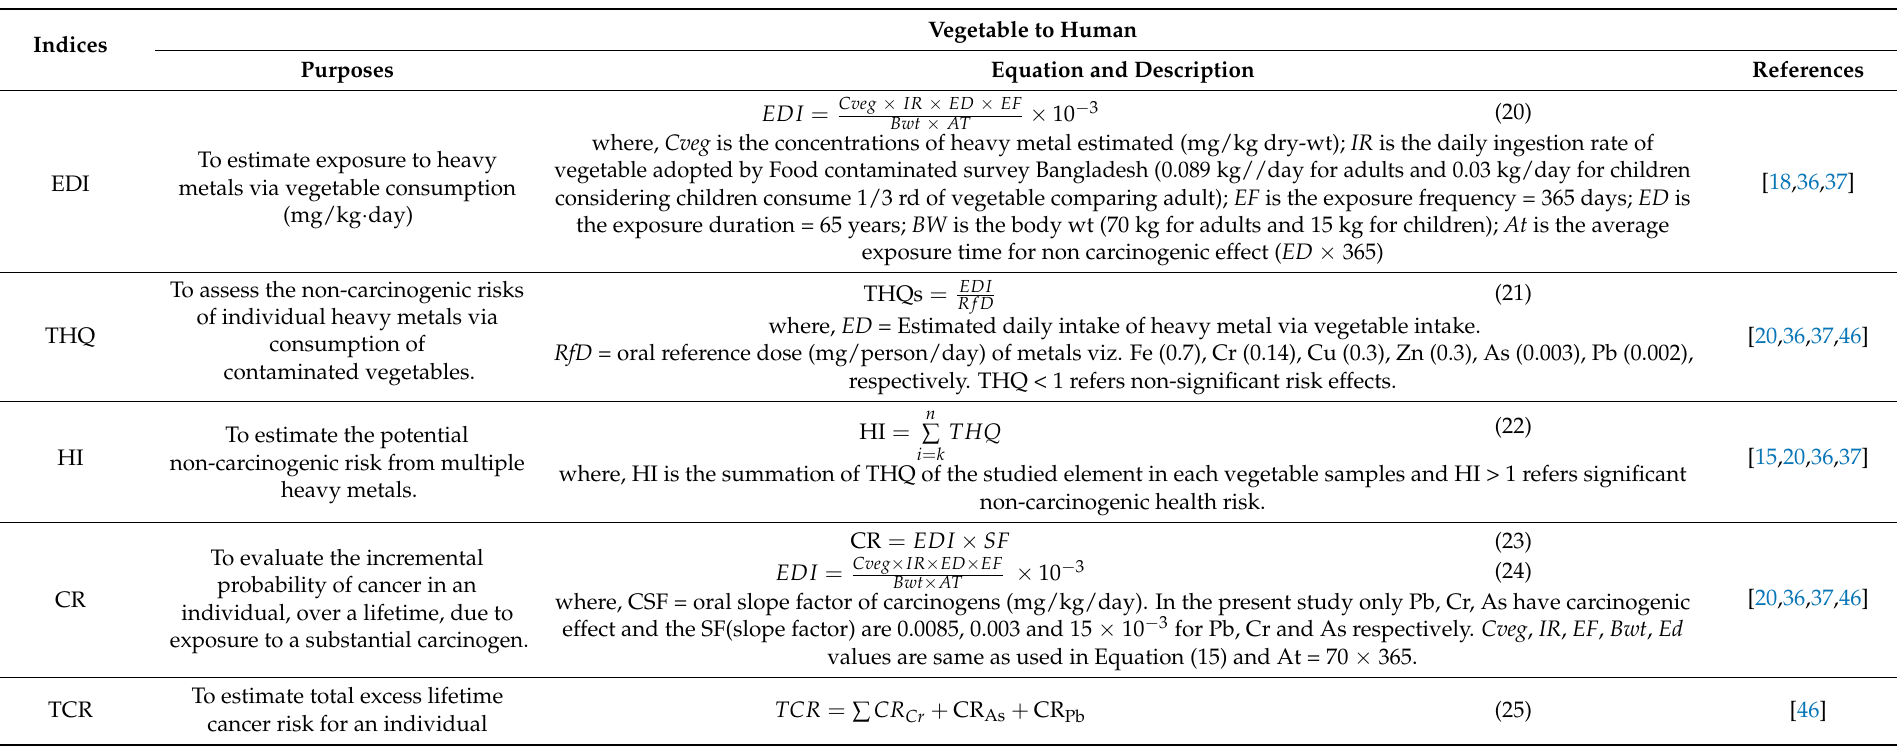
Table 2. Description of the health risk indices utilized to estimate heavy metal impact from soil–vegetable-